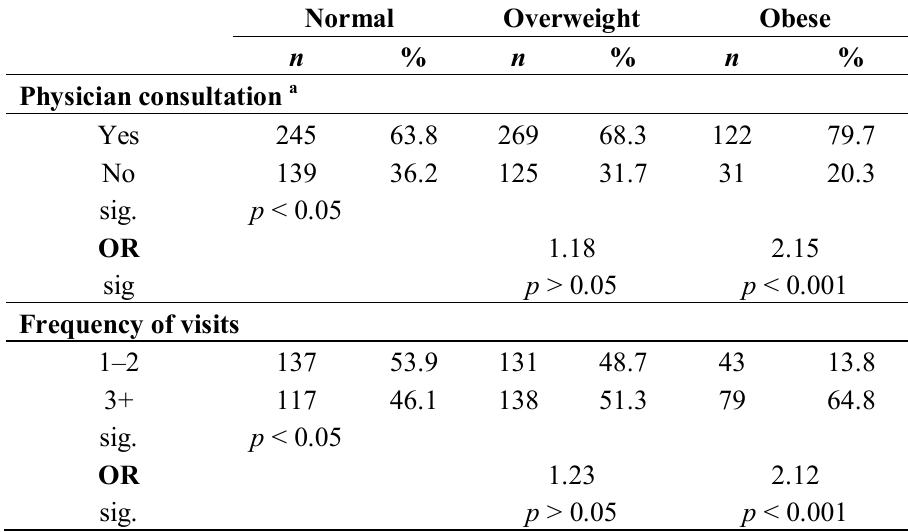
Table 2. Use, frequency of use and odds ratio (OR) estimates according to BMI. Normal Overweight Obese n % Physician consultation